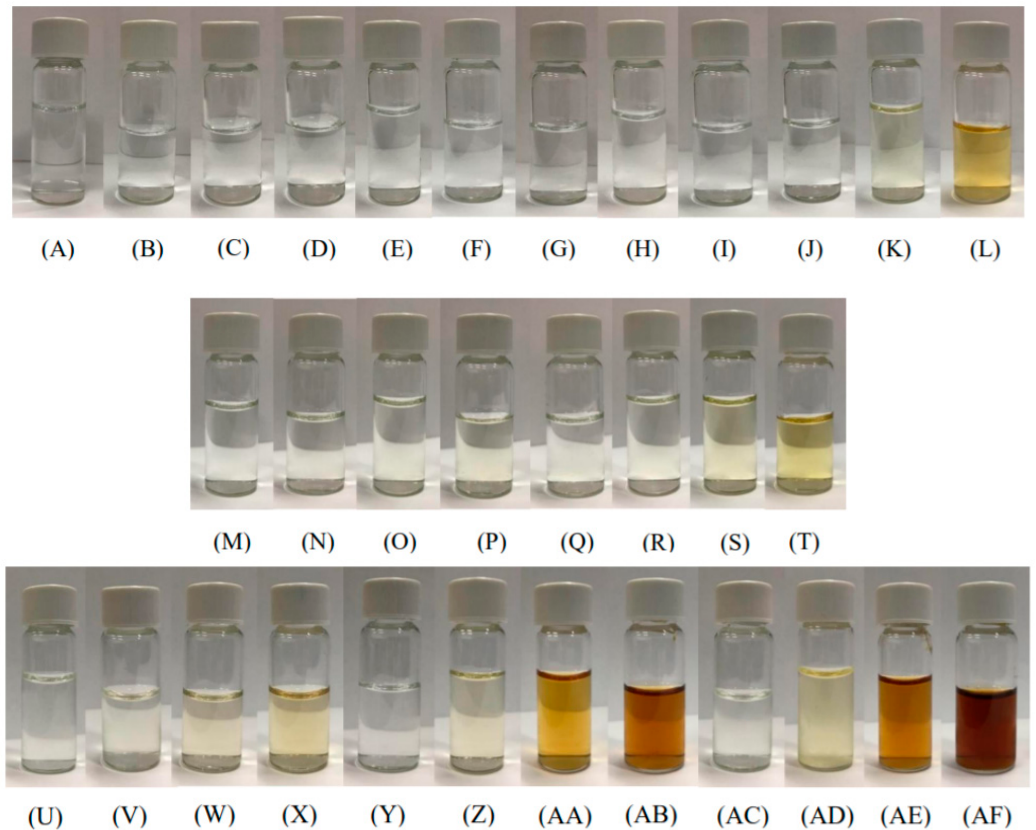
Figure 5. Appearance of solution groups heated at different processing duration. V: acetic acid; AG: asparagine + glucose; A: asparagine; G: glucose; H: hydroxymethylfurfural; HA: hydroxymethylfurfural + asparagine; C: chitosan; AGC: asparagine + glucose + chitosan. ( A ) G 0 min; ( B ) G 10 min; ( C ) G 20 min; ( D ) G 30 min; ( E ) A 0 min; ( F ) A 10 min; ( G ) A 20 min; ( H ) A 30 min; ( I ) AG 0 min; ( J ) AG 10 min; ( K ) AG 20 min; ( L ) AG 30 min; ( M ) H 0 min; ( N ) H 10 min; ( O ) H 20 min; ( P ) H 30